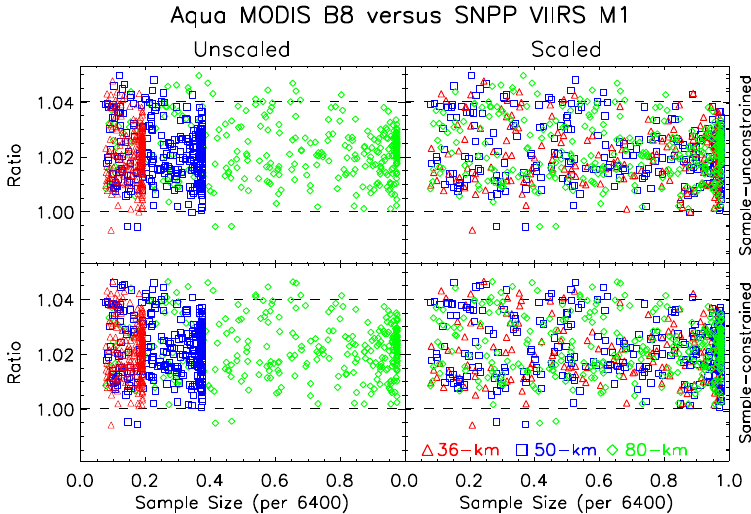
Figure 14. Ratio versus sample size for Aqua MODIS B8 versus SNPP VIIRS M1 for unscaled (top) and the scaled (top right) ratio result under the sample-unconstrained condition, and for the corresponding unscaled (bottom left) and scaled (bottom right) ratio results under the sample-constrained condition.